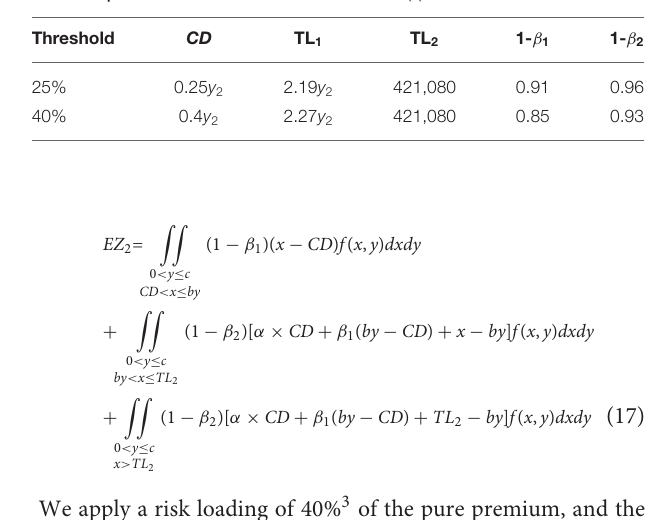
TABLE 8 | Indicators of the CII model in the ATP